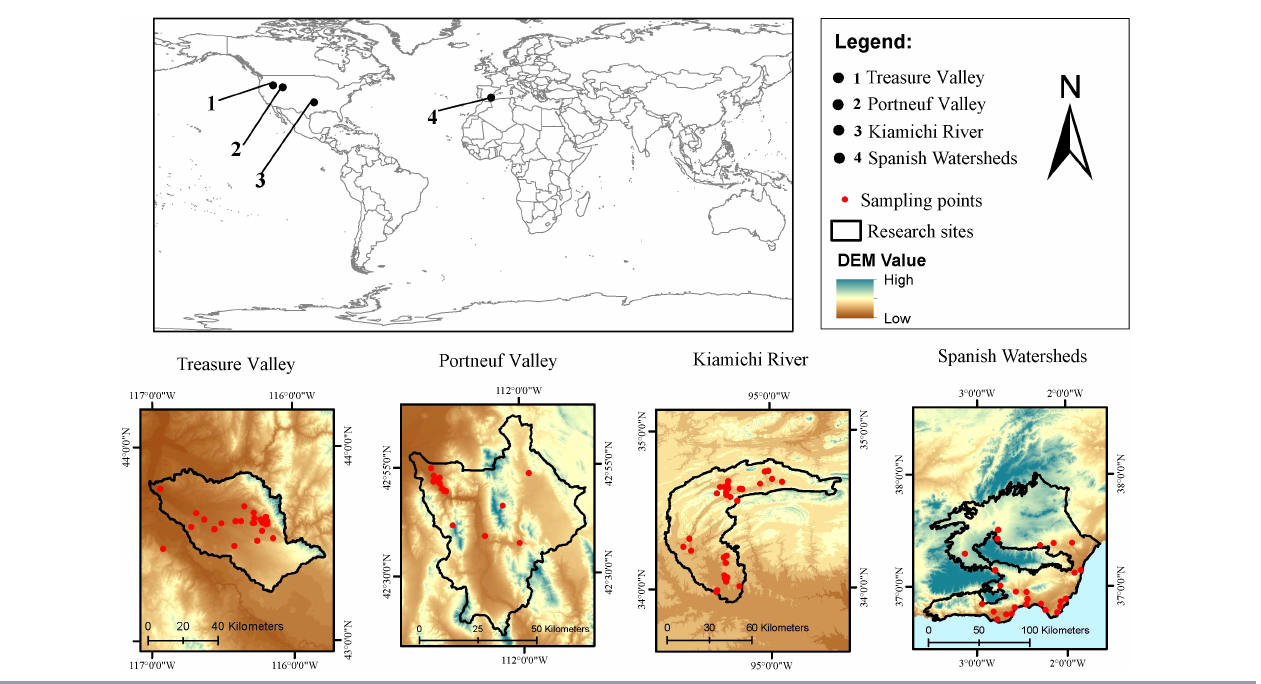
Fig. 1. Map of the locations of the four place-based research